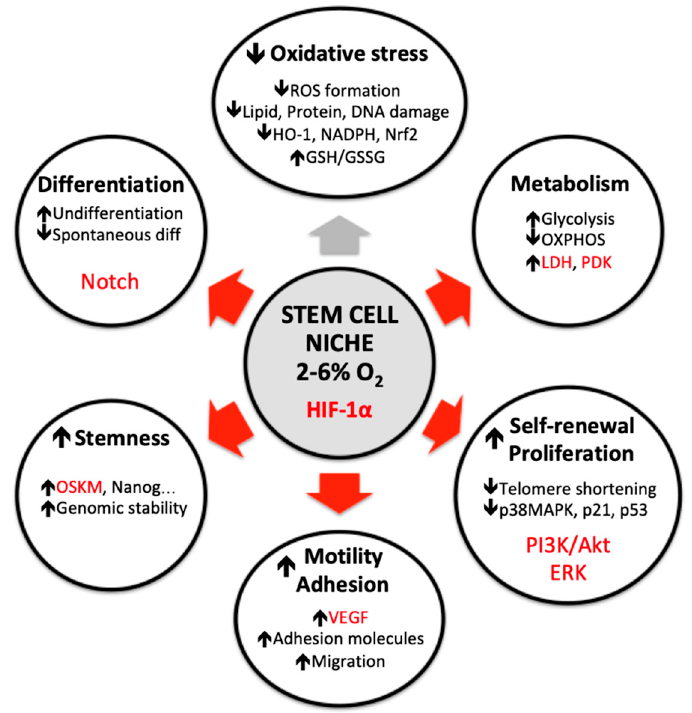
Figure 2. Benefits of low oxygen tension on stem cells behaviour. HIF-1 α implication is shown in